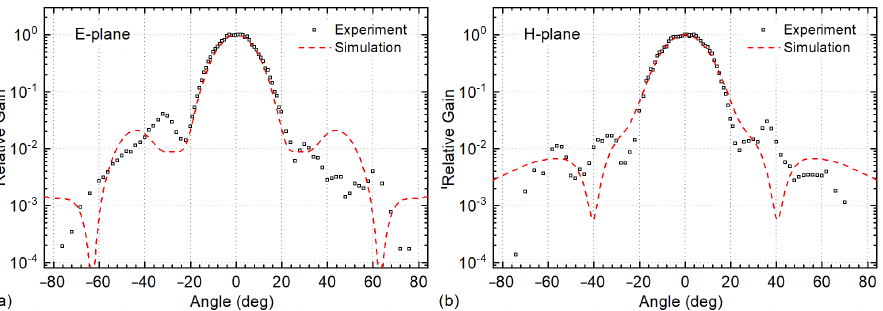
Figure 3. Dependency of the THz response of the resonant detector on ( a ) E-plane and ( b ) H-plane tilt angles at 252 GHz. The simulated response is displayed with the dashed line.